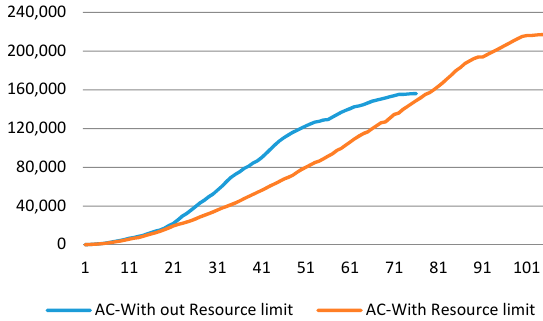
Figure 16. Simulator output with and without resource leveling. AC, Actual Cost.